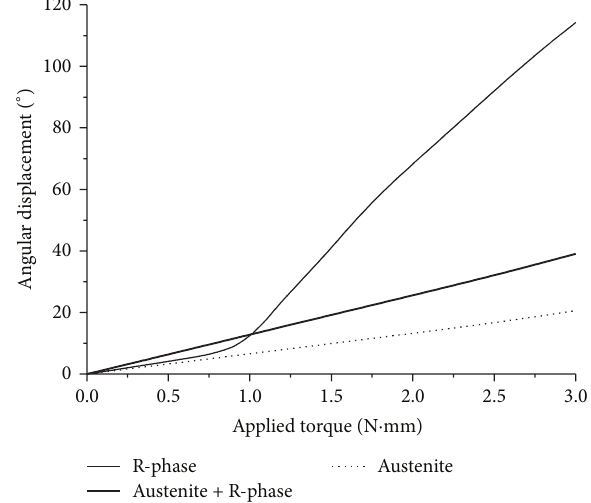
Figure 9: Simulated torsion-torque curves for the same endodontic instrument with three different NiTi constitutive models: austenite, austenite + R-phase, and